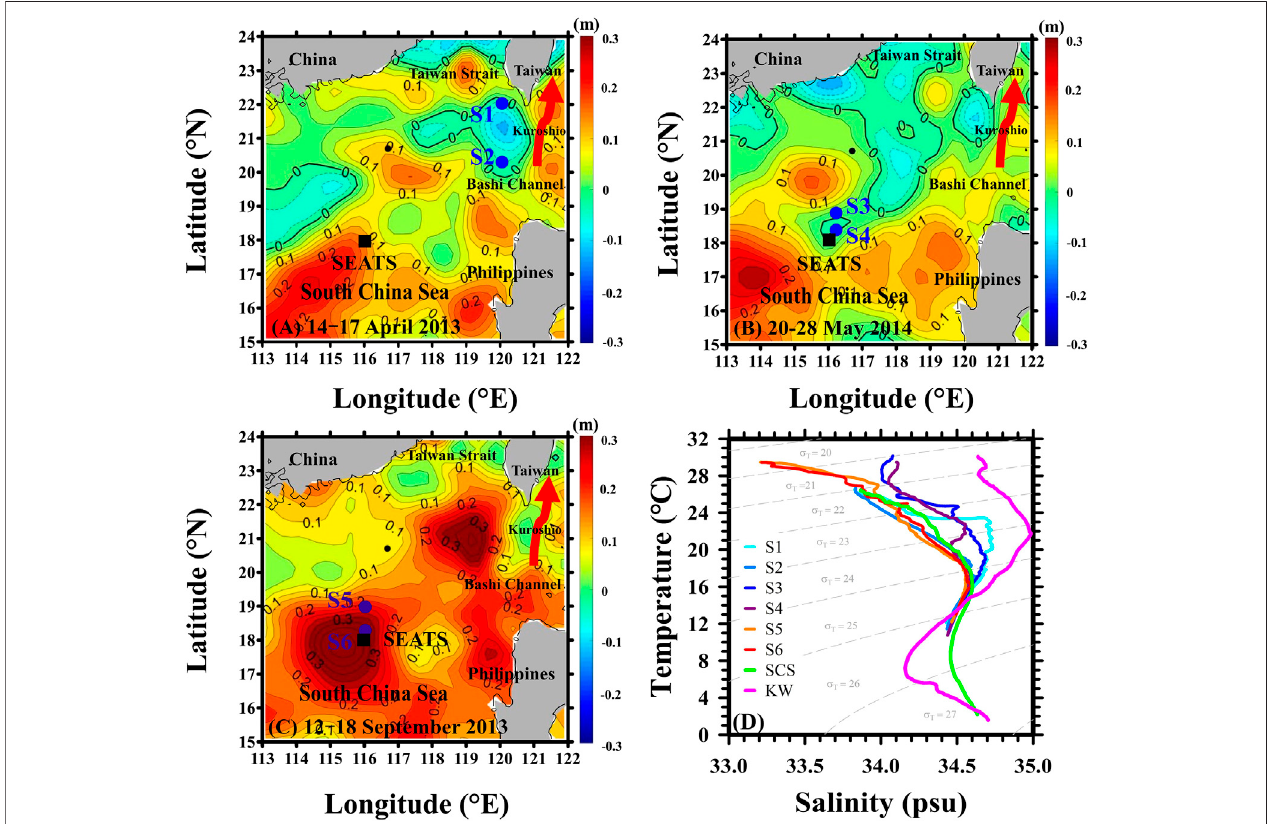
FIGURE 1 | Maps showing the locations of the main sampling stations (solid circles, S1 to S6) in the NSCS in (A) April 2013 (cold eddy), (B) May 2014 (cold eddy) and (C) September 2013 (warm eddy). Contour plots of sea level anomaly (SLA, unit: m) were obtained from the Copernicus Marine Environment Monitoring Service (CMEMS) and are based on comprised daily measurements within 0.25 × 0.25 grid cells (http://marine.copernicus.eu). Solid and dashed lines represent positive (warm eddy) and negative (cold eddy) SLAs, respectively. (D) T − S diagrams for the upper 300 m of the water column at stations S1 to S6 including the T − S diagrams of the South China Sea (SCS) and the Kuroshio waters (KW, thick red arrows in A – C ). The SEATS site is represented with a square symbol.